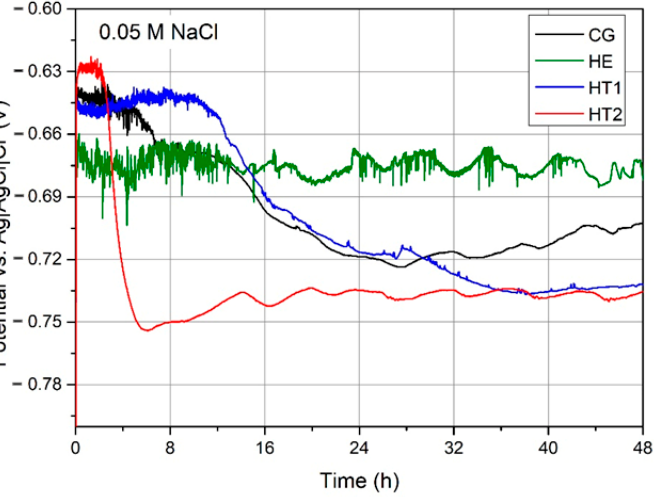
Figure 10. E OCP over time for the CG, HE, HT1, and HT2 AA 7075 samples during 48 h immersion in 0.05 M NaCl. 0.05 M